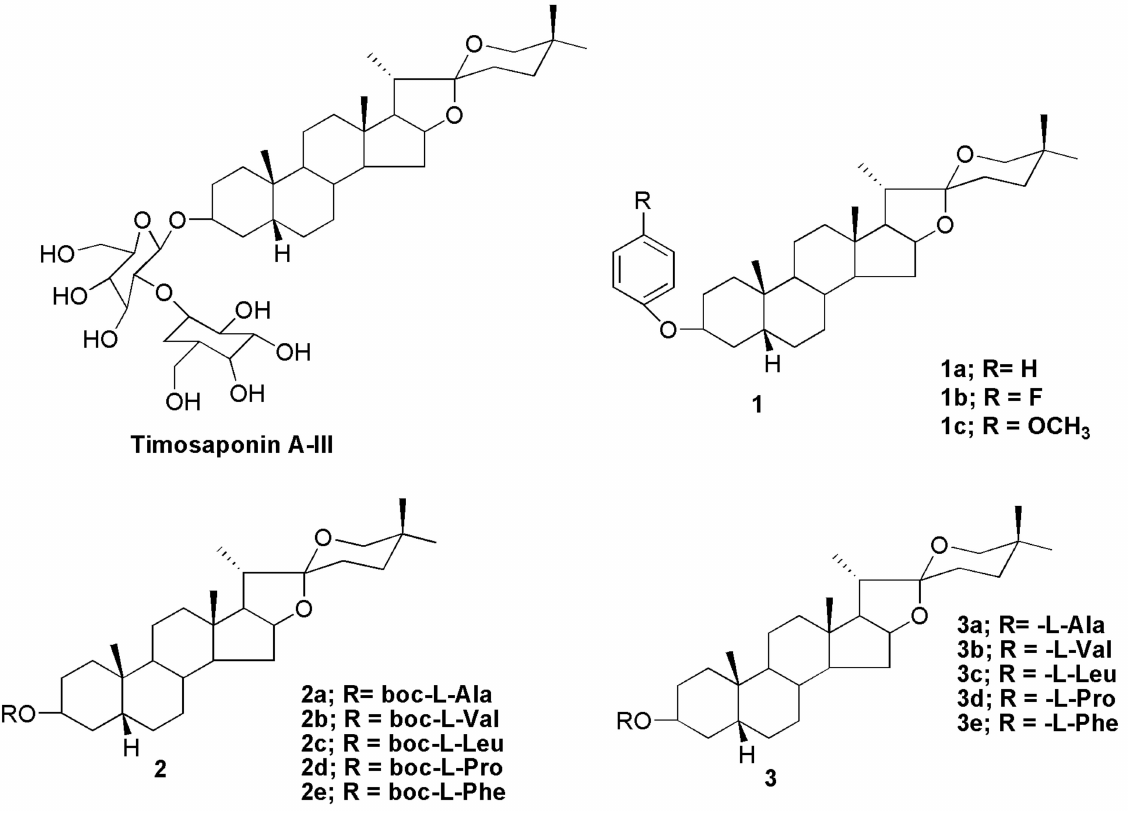
Figure 7. Chemical structures of sarsasapogenin-derived compounds ( 2a – 2e and 3a – 3e